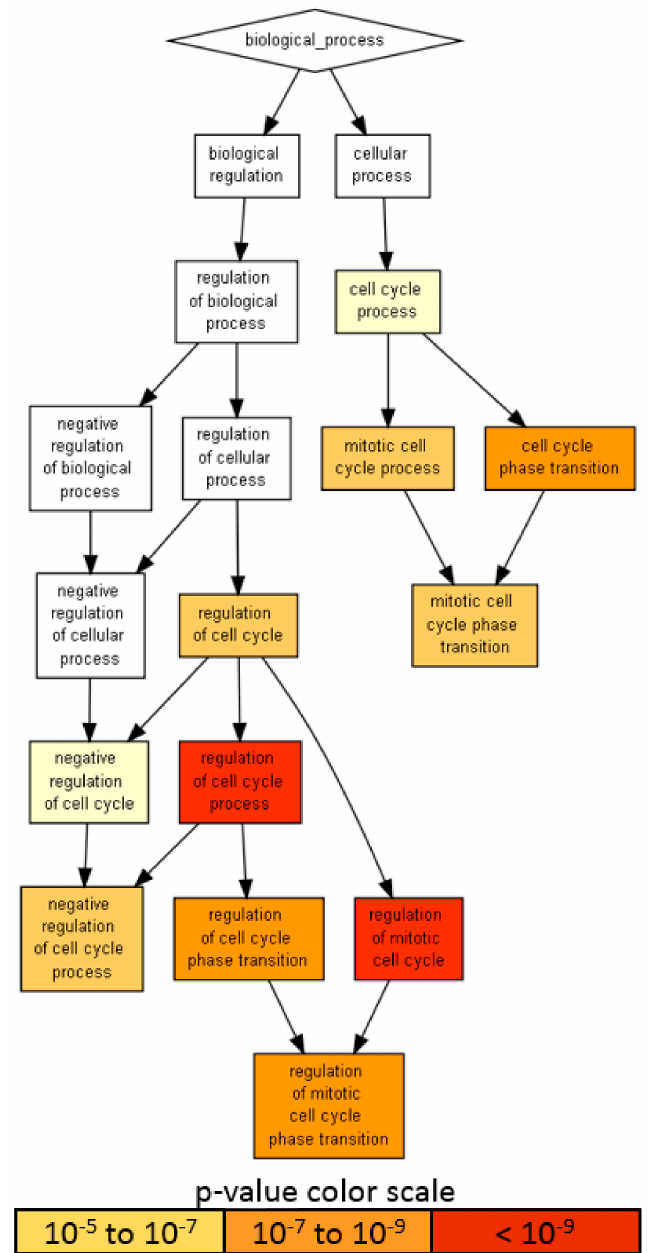
Figure 6. A visualization of the biological process gene ontology annotations using Gorilla for targets of abundant EV-miRNAs. The background dataset used is composed of the entire human genome. Enrichment using the 818 mRNAs verified as targets of EV-miRNAs in the first quartile of expression. The Gorilla settings were left at default values: p -value threshold of p < 10 − 6 , organism Homo sapiens. 2.5. Target and E ff ect Prediction of EV-miRNAs on